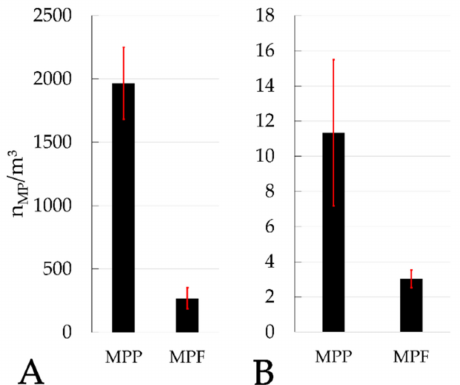
Figure 6. Average number of identified MPP and MPF of samples 1–3 in treated wastewater of Frankfurt Sindlingen WWTP in final clarifier effluent ( A ) and sand filter effluent ( B ). The MPP identified in the effluent of the final clarifier of the Frankfurt Sindlingen